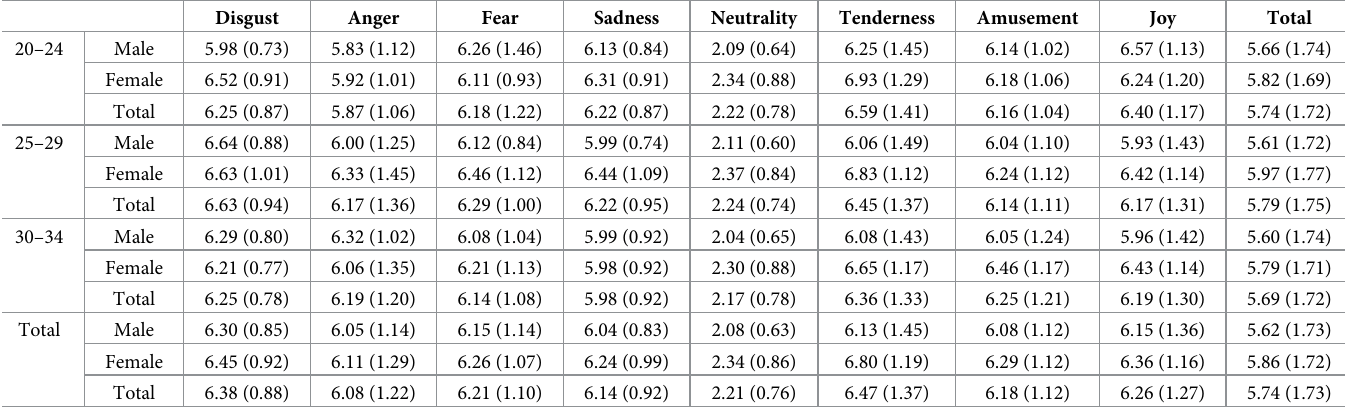
Table 2. The descriptive statistical results on the arousal